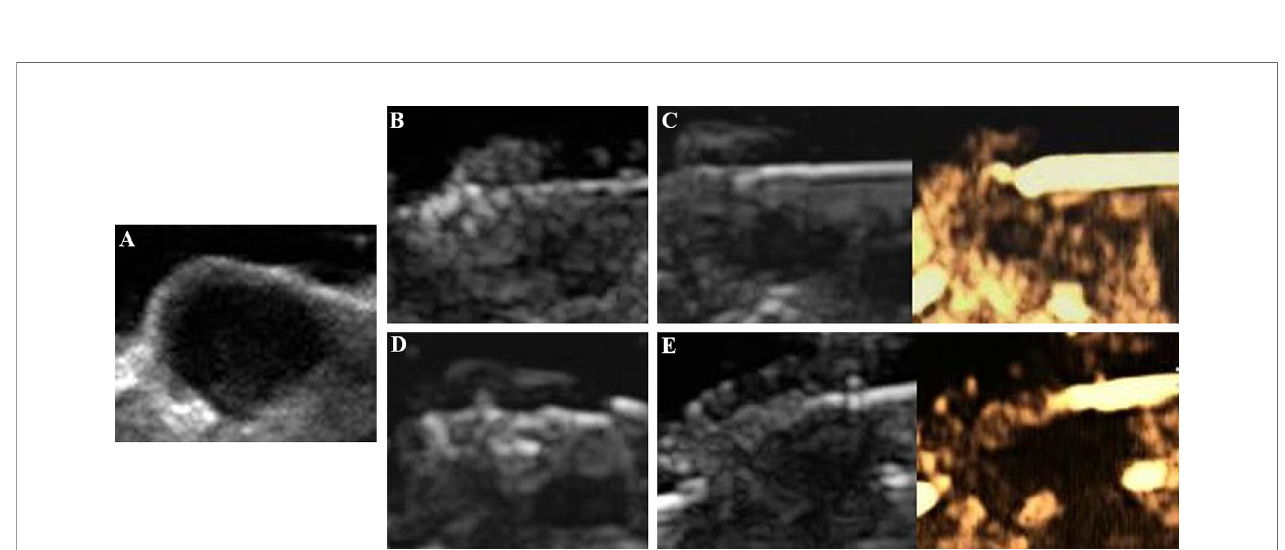
FIGURE 7 | Evaluation of the breast cancer (4T1) in nude mice by SonoVue after MWA: (A) before MWA, (B) the ablation process, (C) contrast agent perfusion was detected in the periphery of the tumor after MWA. A secondary ablation: (D) a complementary ablation, (E) It was con fi rmed by CEUS that the complementary ablation was complete.